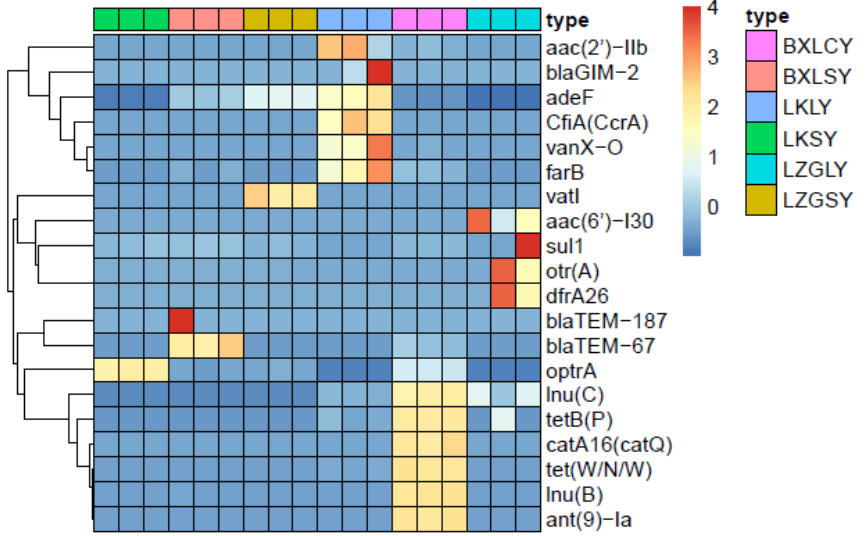
Figure 4. Heatmap of ARGs in different samples. BXLCY, LKLY and LZGLY were fish gut content sample groups of BXL, LK and LZG fish farm, respectively. All water sample groups were